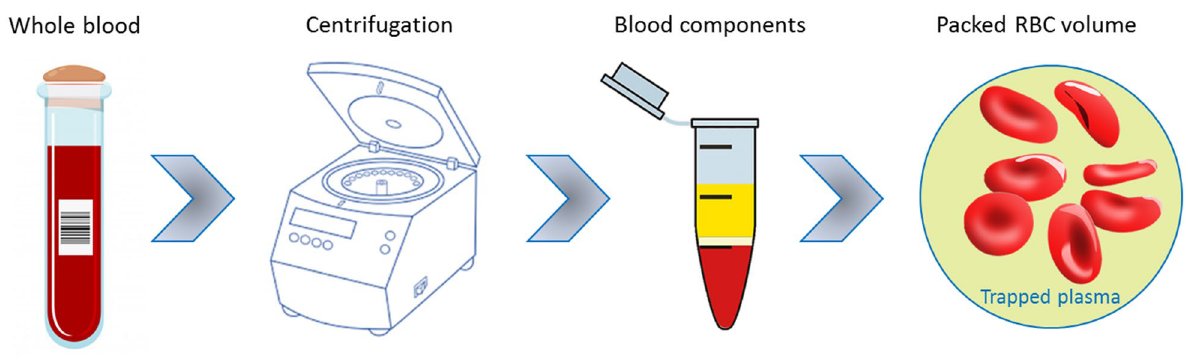
Figure 3. Schematic representation of plasma entrapment during Hct measurements by the PCV